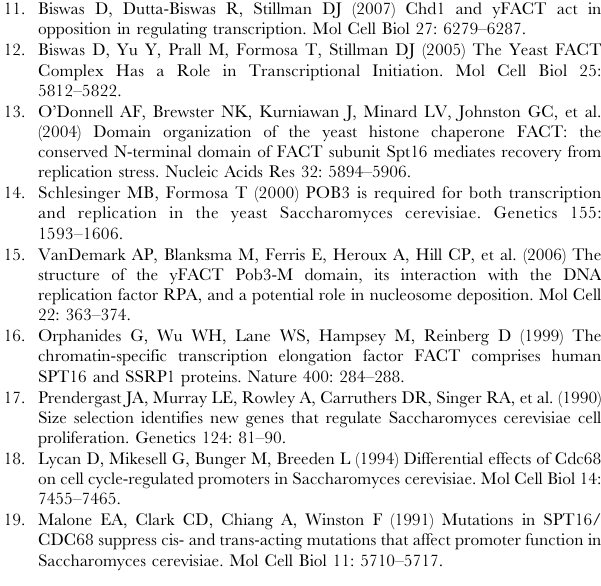
Figure S4 hta2/htb2 D partially suppresses the thermosensitivity of spt16-197 . (A) Strains FY120, FY348, FY710, DMY10, DMY11, and DMY12 were transformed with pRS316 (empty vector), pRS316-HTA1-HTB1 or pRS316-HTA1-HTB1 D NEG. Transformants were grown in SC-Ura medium at 25 u C. 10-fold serial dilutions of the indicated strain were plated on SC-Ura plates and incubated for three days at the indicated temperatures. The chromosomal, extrachromosal or plasmidic copies of HTA1– HTB1 and HTA2–HTB2 presented in each transformant are indicated. Red squares indicate the results of those strains containing two copies of H2A/H2B-encoding loci. (B) An extrachromosomal amplification of the HTA2–HTB2 locus was detected by PCR in FY710 ( hta1/htb1 D ) and DMY11 ( spt16-197 hta1/htb1 D ), following the protocol described in (Libuda and Winston, 2006). Figure S5 spt16-197 does not affect the levels of histone chaperones Nap1 and Asf1 or alter histone gene regulation. (A) Nap1 levels were unaffected in spt16-197 . Nap1-FLAG was detected in WCEs of 4 independent generated wild type and spt16-197 strains by Western blotting using an anti-FLAG antibody. A non-specific band was used as the loading control. (B) Asf1 levels were unaffected in spt16-197 . Asf1-FLAG was detected in WCE by Western blot with an anti-FLAG antibody. H2A was used as the loading control. (C) Alpha–amanitin inhibited RNA pol II transcription in alpha-factor-synchronized spt16-197 cells. The mRNA levels of the constitutively expressed ACT1 gene were measured by quantitative RT-PCR in the FY348 cells grown exponentially at 25 u C and synchronized with alpha factor for four hours. The data was normalized to the levels of ribosomal RNA which is not affected by the concentration of alpha–amanitin used. (D) Repression of histones genes in G1 was not abolished by spt16-197 . Wild-type (FY120) and spt16-197 (FY348) cells grown asynchronously (AS) were synchronized at START (ST) by treatment with alpha-factor for two hours at 25 u C (ST), followed by an additional one hour at 25 u C or 35 u C in the